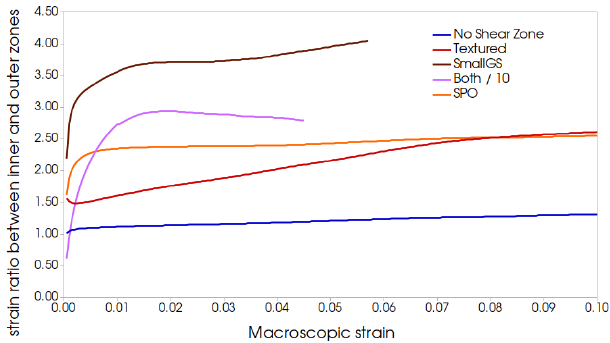
Figure 6. Ratio of the cumulated average strain for the inner part over the one for the outer parts of the sample for the different type of pre-existing shear